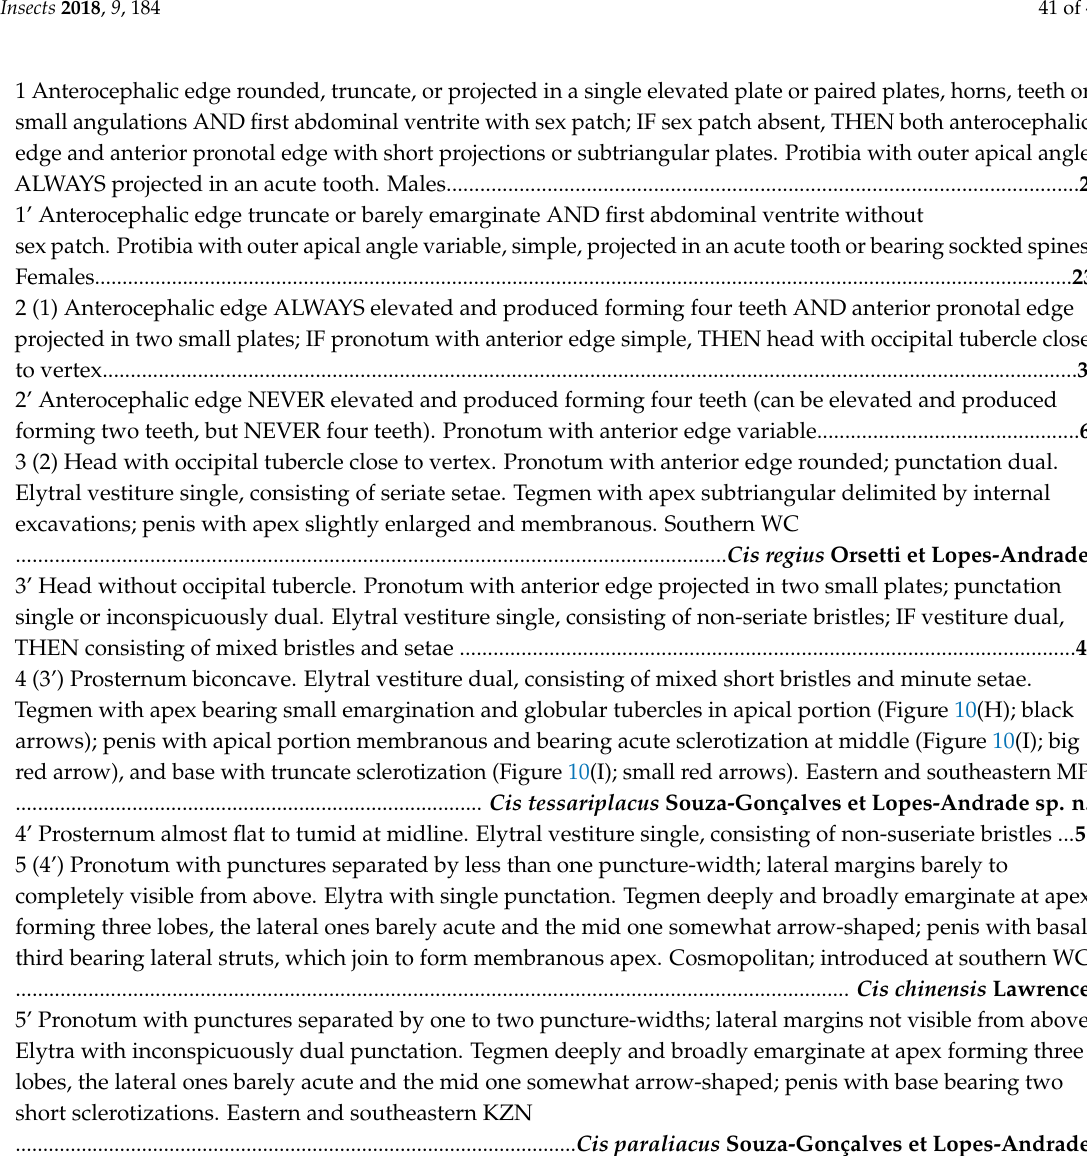
one-third the length of first ventrite at midline. Tegmen bearing deep emargination at apex; penis subcylindrical and with apex bearing shallow emargination. Southern WC